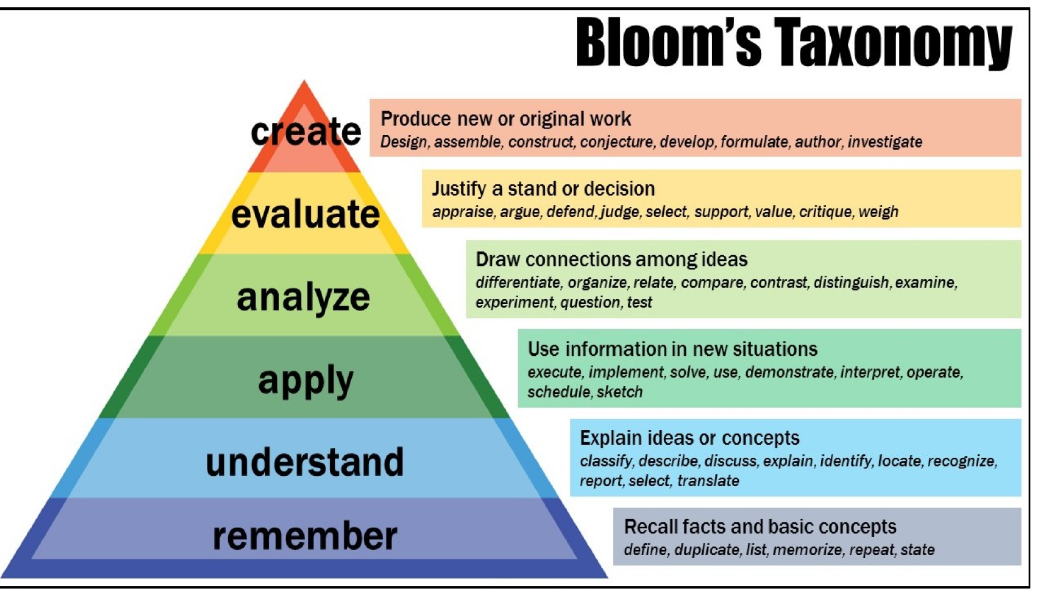
Figure 3. Bloom’s Taxonomy of Cognitive Goals